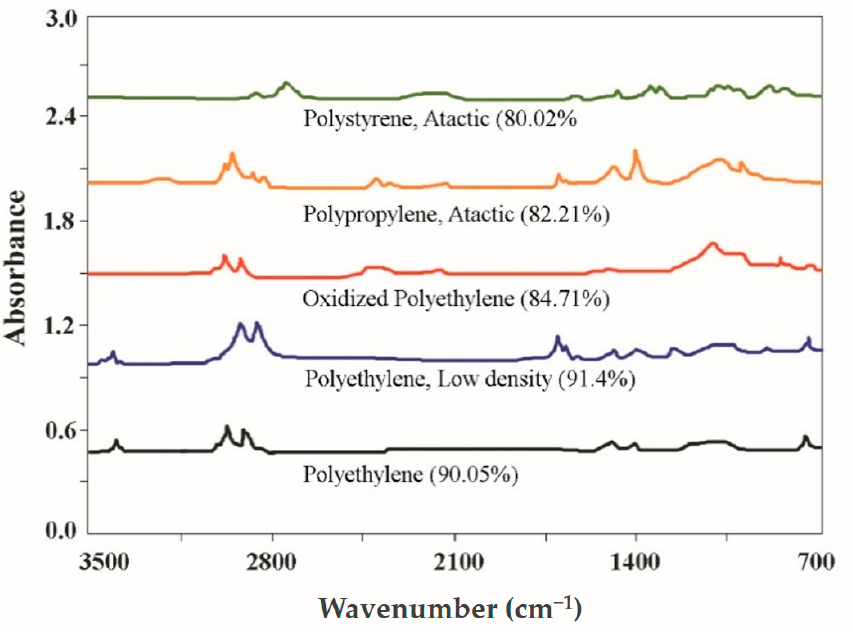
Figure 10. The FTIR spectrum of selected MPs detected in soil samples and the match degrees with the standard spectrum.